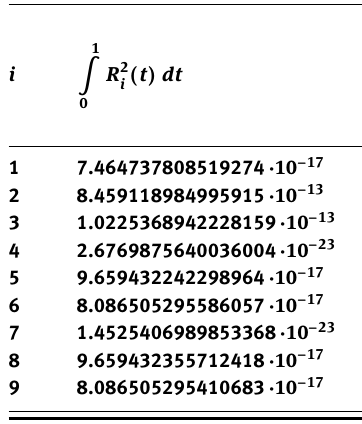
Table 4. The numerical values of the integral of square residual function given by Eq. (27) corresponding to the approximate solutions given by Eqs. (28)-(36) for M = 15 and P = 20